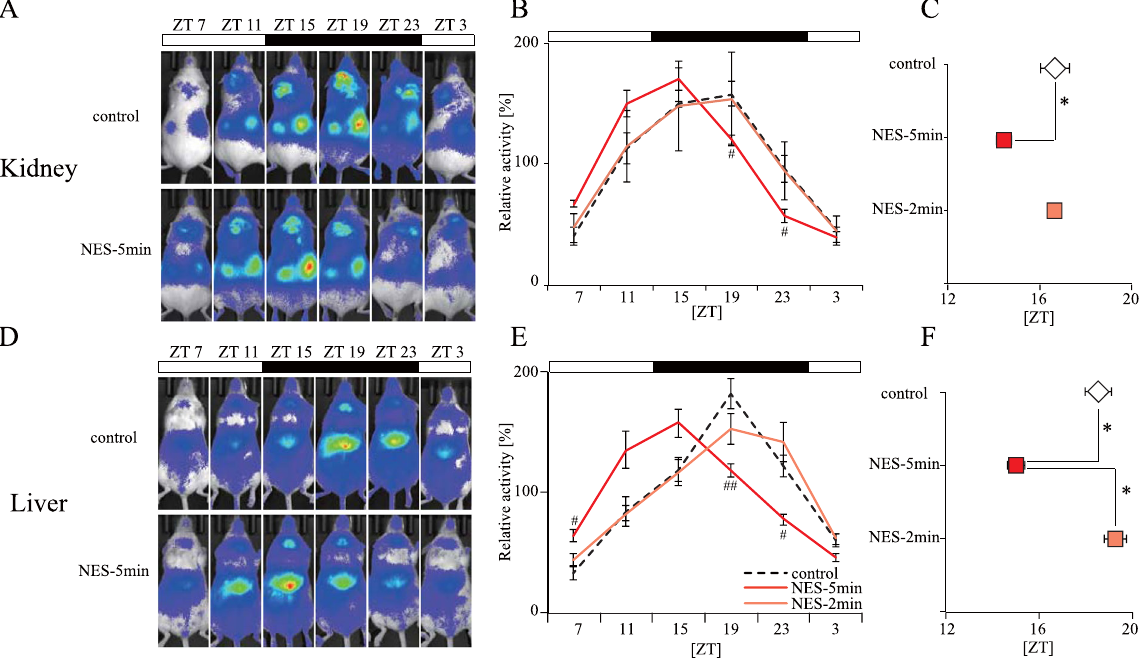
Figure 3. Effect of RF duration of 5-min and 2-min with HFD at ZT 5 on peripheral clocks (Experiment 3). ( A – F ) Representative images ( A and D ), analyzed wave forms ( B and E ), and peak phases ( C and F ) of in vivo PER2::LUC bioluminescence in the kidney ( A – C ) and the liver ( D – F ). Open and closed bars indicate light and dark periods, respectively. Data are presented as the mean ± SEM (control group, n = 6; NES-5 min group, n = 5; NES-2 min group, n = 3). * p < 0.05 (one-way ANOVA with Tukey’s multiple comparison test). # p < 0.05, ## p < 0.01 vs. the control group (Kruskal-Wallis test with Dunn’s multiple comparison